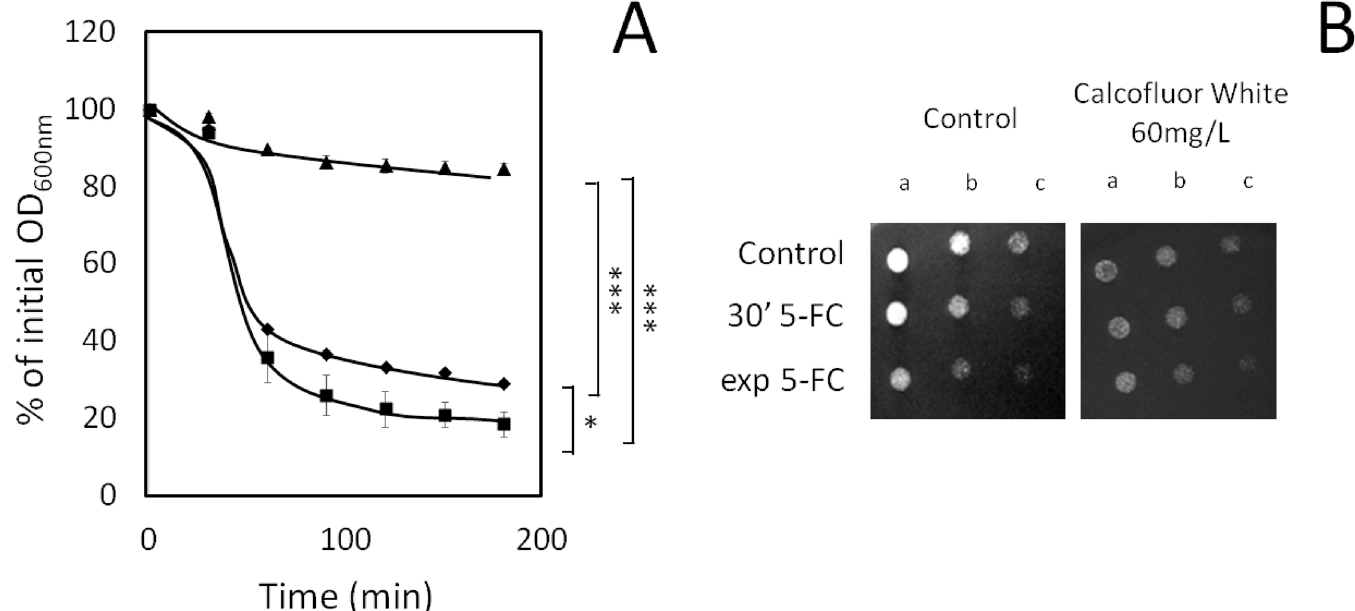
Fig 3. Cell wall damage followed by remodeling occurs during adaptation to 5-flucytosine stress. A) C . glabrata KUE100 cells exposed to lyticase stress were harvested in the exponential phase of growth in the absence of stress ( ♦ ) or upon 30 min of exposure to 0.7 mg/L 5-flucytosine ( ■ ), or in the exponential phase of growth reached upon adaptation to 0.7 mg/L 5-flucytosine ( ▲ ). The different cell populations were washed with water and resuspended in 0.1M sodium phosphate buffer at pH 7.5. After addition of 20mg/L lyticase, the decrease in the OD 600nm of the cell suspension was measured periodically and indicated as a percentage of the initial OD 600nm . The indicated values are averages of at least three independent experiments. Error bars represent the corresponding standard deviation. * P < 0.05; *** P < 0.001. B) Comparison, by spot assays, of the susceptibility of C . glabrata KUE100 cells harvested in the exponential phase of growth in the absence of stress (control) or upon 30 min of exposure to 0.5 mg/L 5-flucytosine (30 ’ 5-FC), or in the exponential phase of growth reached upon adaptation to 0.5 mg/L 5-flucytosine (exp 5-FC) to Calcofluor White, in MMB agar plates. The inocula were prepared as described in Materials and Methods, and the cell suspensions used to prepare the spots 1:5 (b) and 1:25 (c) dilutions of the cell suspension used for column a. The images are representative of at least three independent experiments.